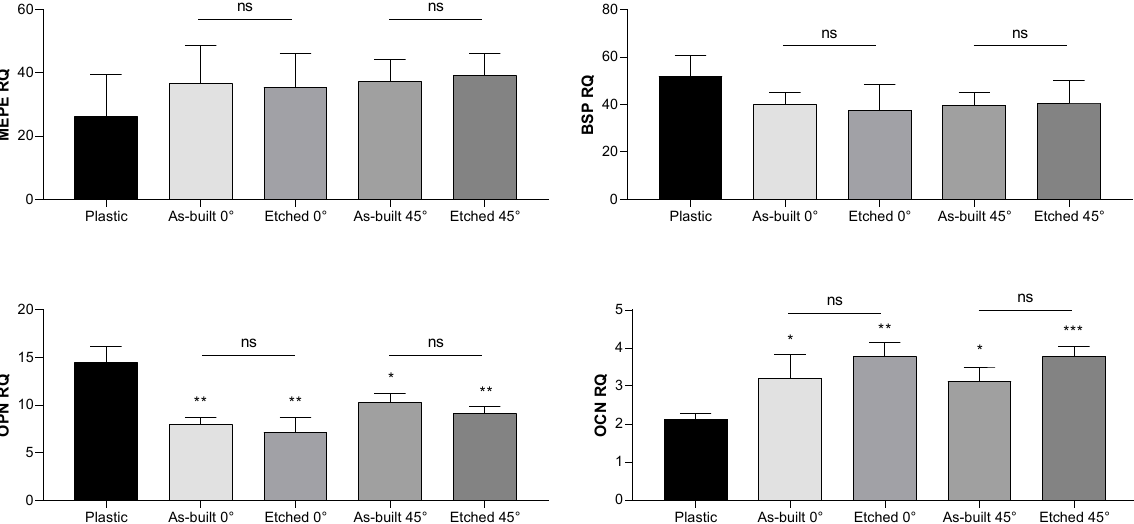
Figure 7. Gene expression evaluation of MC3T3-E1 cells cultured in mineralization medium after 30 days on titanium as-built and etched (0° and 45°) SLM scaffolds and on a plastic well plate. Unpaired t -test was applied to discriminate differences between plastic dish and each scaffold considering a statistically significant value of p < 0.05 (* p < 0.05, ** p < 0.01, *** p < 0.001,). Unpaired t -test was used also to compare as-built substrates and relative etched scaffolds (“ns” indicates not significant, p > 0.05) .